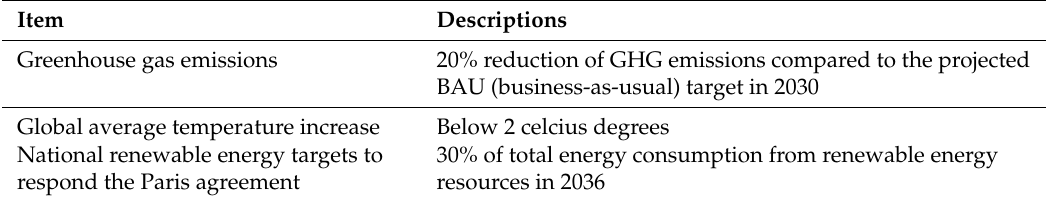
Table 2. Key points which are applied to Thailand in the Paris Agreement [6,7]. Item